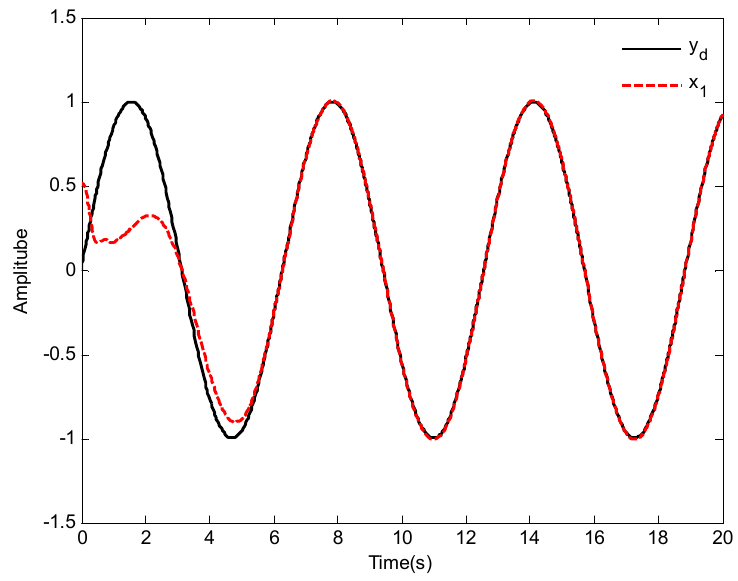
Figure 9. The curves of tracking performance.